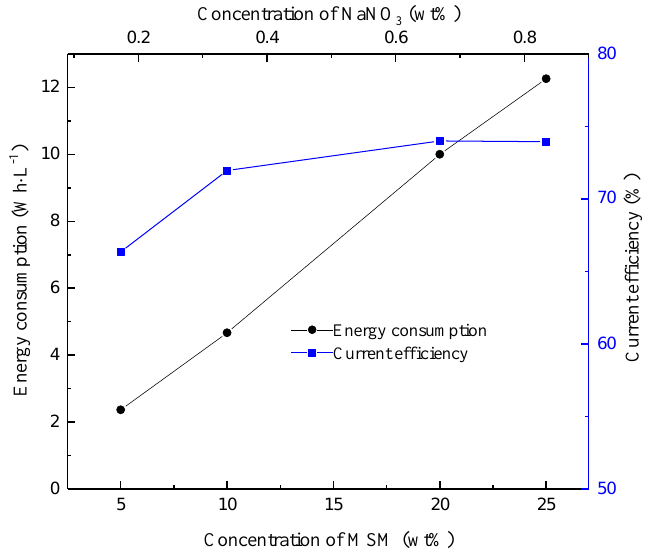
Figure 7. Energy consumption and current e ffi ciency under di ff erent concentrations of MSM. The NaNO 3 concentrations were 0.17%, 0.35%, 0.70%, and 0.83%, respectively, when the MSM concentrations were 5%, 10%, 20%, and 25%.